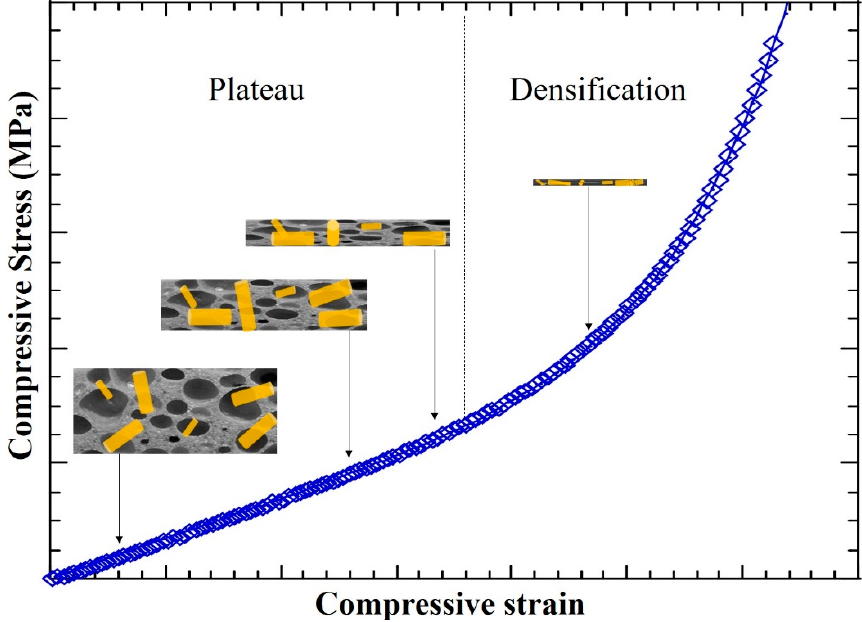
Figure 11. Visualization of bamboo fiber effect during plateau and densification regions.